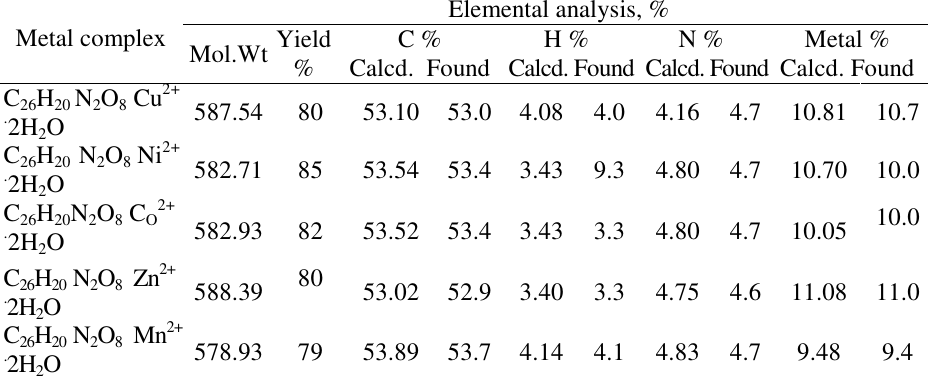
Table 1. Analysis of FMBA - metal